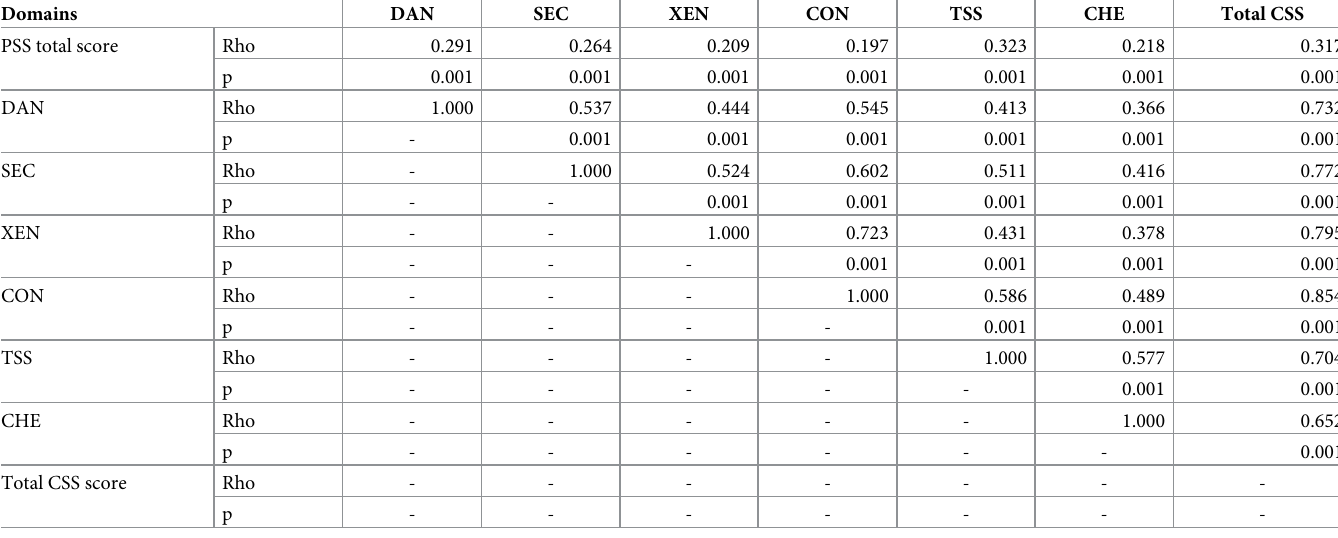
Table 3. Correlations between the COVID Stress Scales and Perceived Stress Scale total